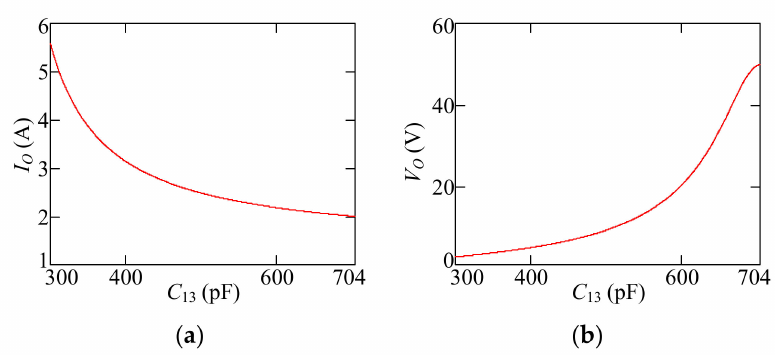
Figure 18. The effect of the change in the length of air gap between the plates on CC/CV conditions. ( a ) the output current at CC mode ( b ) the output voltage at CV mode.